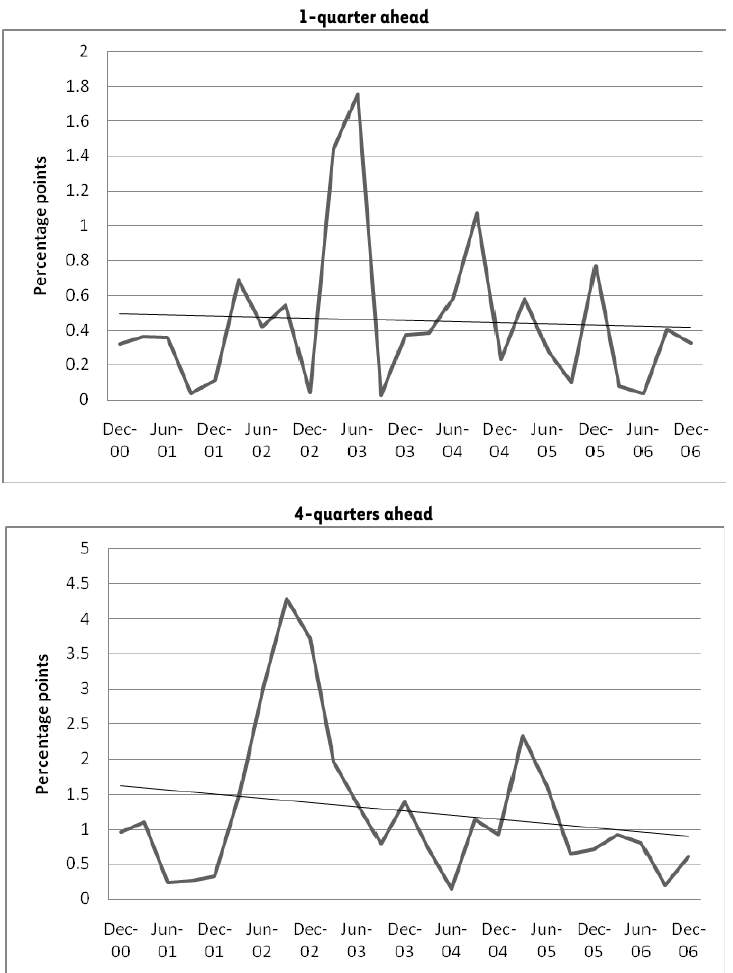
FIGURE 8a: CPIX Inflation: Forecast Errors,